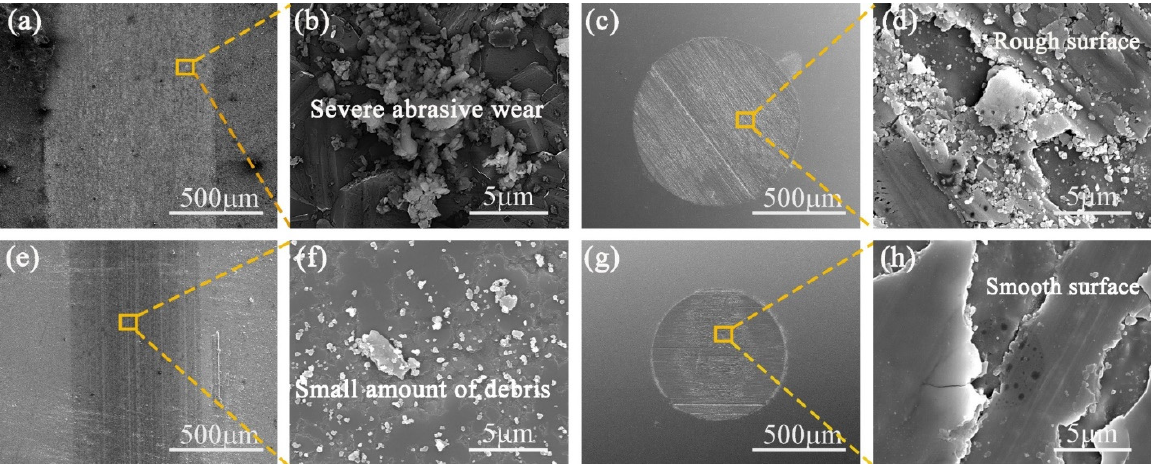
Figure 5. ( a , b ) The typical worn scars of MCD coatings sliding against SiC balls in the dry environ- ment; ( c , d ) The typical worn scars of SiC sliding against MCD coatings in the dry environment; ( e , f ) The typical worn scars of NCD coatings sliding against SiC balls in the dry environment; ( g , h ) The typical worn scars of SiC sliding against NCD coatings in the dry